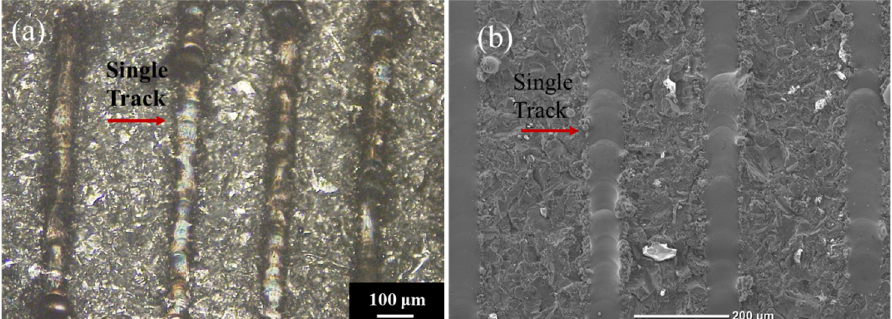
Figure 5. ( a ) OM image and ( b ) SEM image of the single-tracks using FD-POEM MoSiBTiC-La 2 O 3 powders.